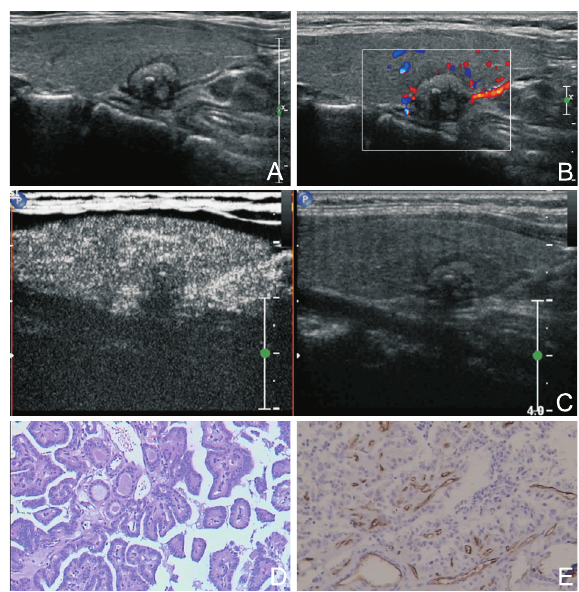
Figure 1 A 39-year-old female with a 1.13*0.91cm nodule in the left thyroid lobe. (A) Gray-scale US showed a hypoechoic solid nodule with calcification in the left lobe of the thyroid gland. (B) CDFI: There was no obvious blood flow in the nodule. (C) The nodule showed hypo-enhancement. (D) Surgical pathology showed a papillary thyroid carcinoma (HE, ×100). (E) Immunohistochemical staining of the thyroid nodule showed a lower microvessel density (CD34, ×100).